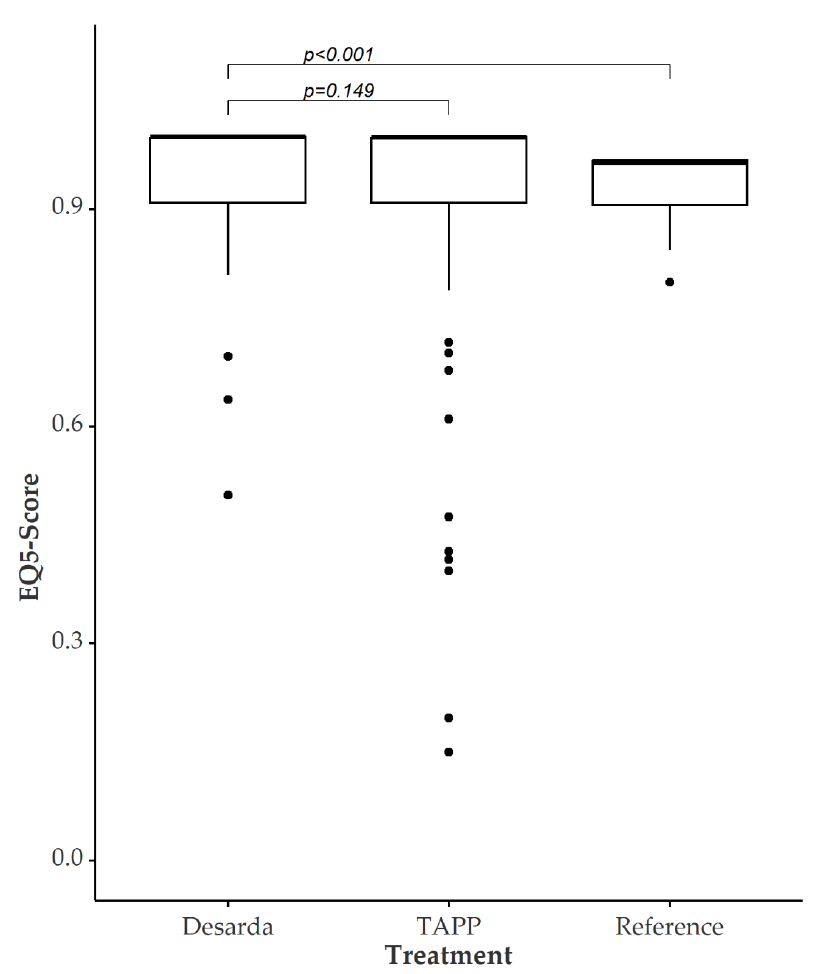
Figure 3. QoL after Desarda vs. TAPP vs. reference population after propensity score matching. n = 241 (Desarda = 98, TAPP = 143); data are given as median and IQR (25% and 75% percentile). Dots represent suspected outliers (≥1.5 IQR).